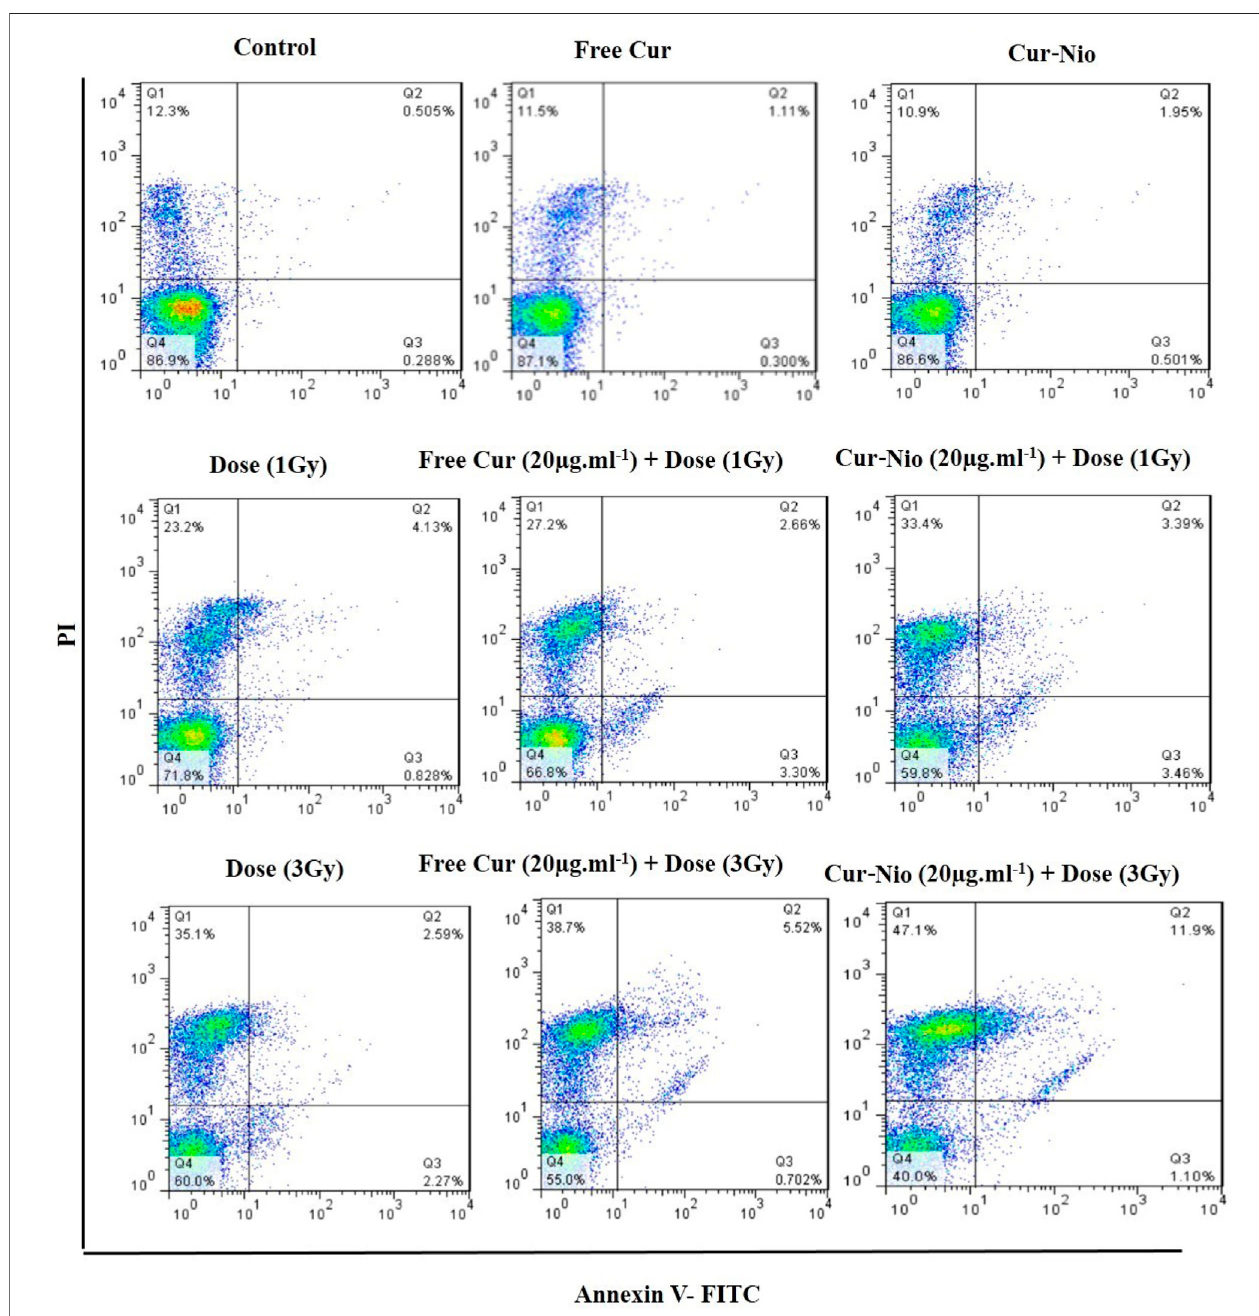
FIGURE 7 | Apoptosis assay using fl ow cytometry, following treatment of cells at 72 h.